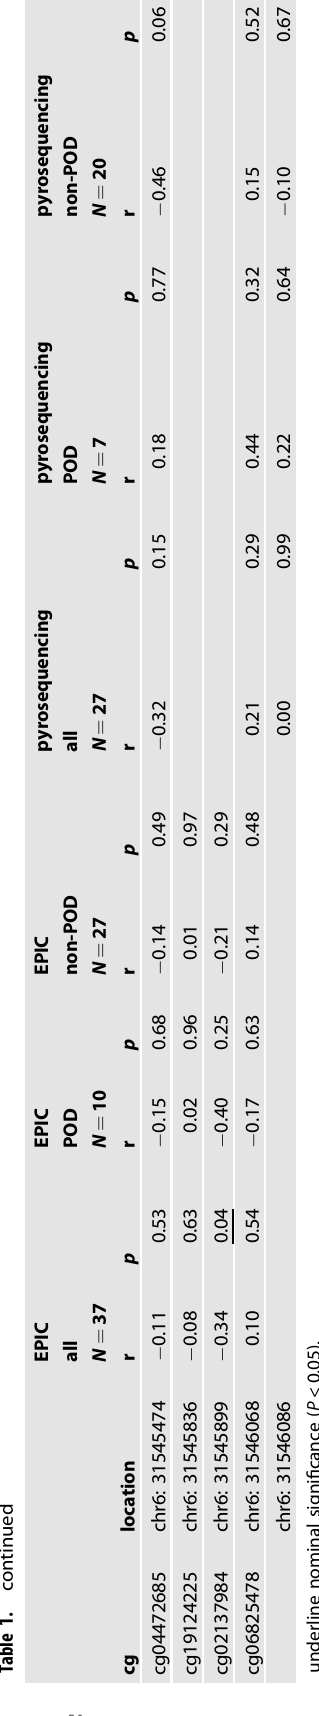
(Supplementary Table 5). DNA methylation after surgery TNF gene . The EPIC analysis demonstrated that there was no signi fi cant difference in DNAm level after surgery between the POD group and the non-POD group (Supplementary Table 6). Moderate negative correlations between age and DNAm level, observed in pre-surgery samples, were observed in several CpG sites (from chr6: 31543546 to chr6: 31543655) on the TNF gene in the POD group, but not in the non-POD group (Table 2). Pyrosequencing analysis did not demonstrate any DNA methylation differences between the POD group and the non-POD group (Supplementary Table 6). In the pyrosequen- cing analysis, negative correlations between age and DNAm were observed in several CpG sites on the TNF gene both in the POD group and in the non-POD group (Table 2).